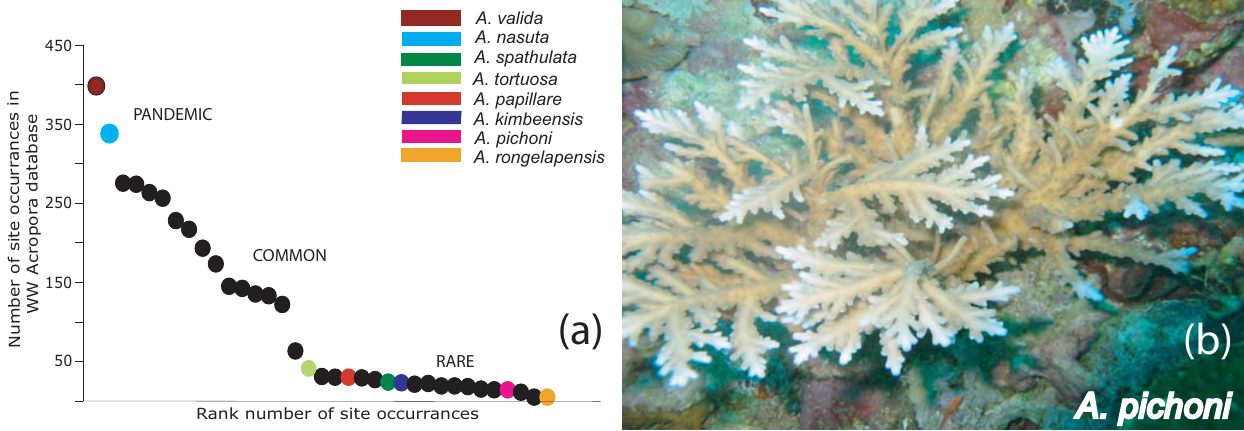
Figure 1. (a). Global abundance of the Acropora species used in this study. These data are based on numbers of records in the World Wide Acropora Database (n=1523 sites; [6] and Wallace unpublished). (b). Several rare species, such as A. pichoni shown here, are likely to be unidirectional hybrids and occupy atypical habitats. Photo credit: Maria Beger.